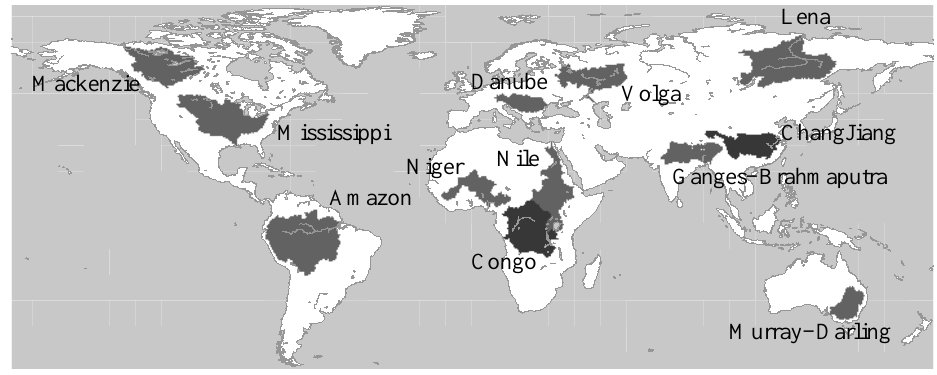
Figure 2: Location of study basins. 4